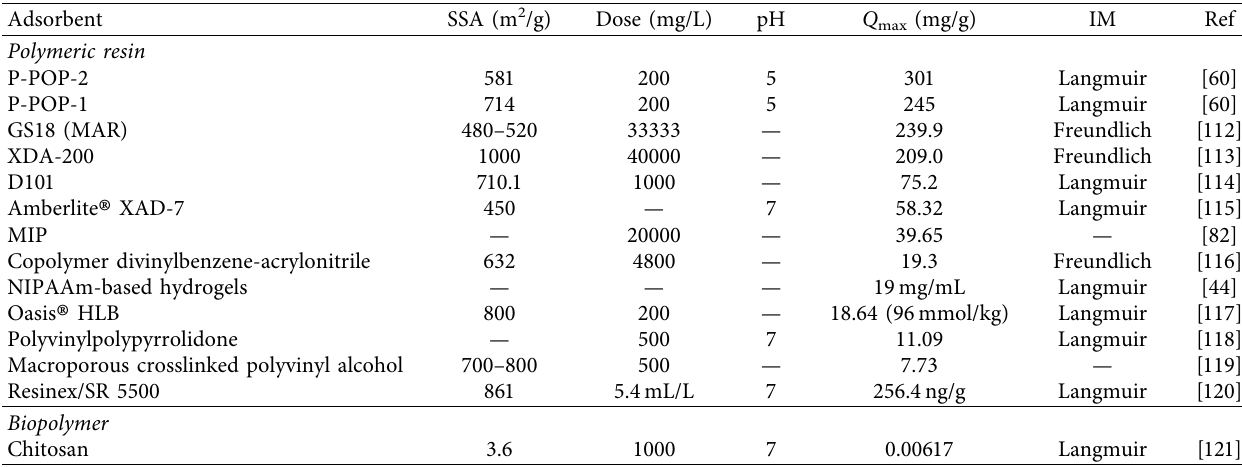
Table 8: Summary of characteristics of polymeric resins and biopolymers and conditions of the adsorption process. Adsorbent SSA (m 2